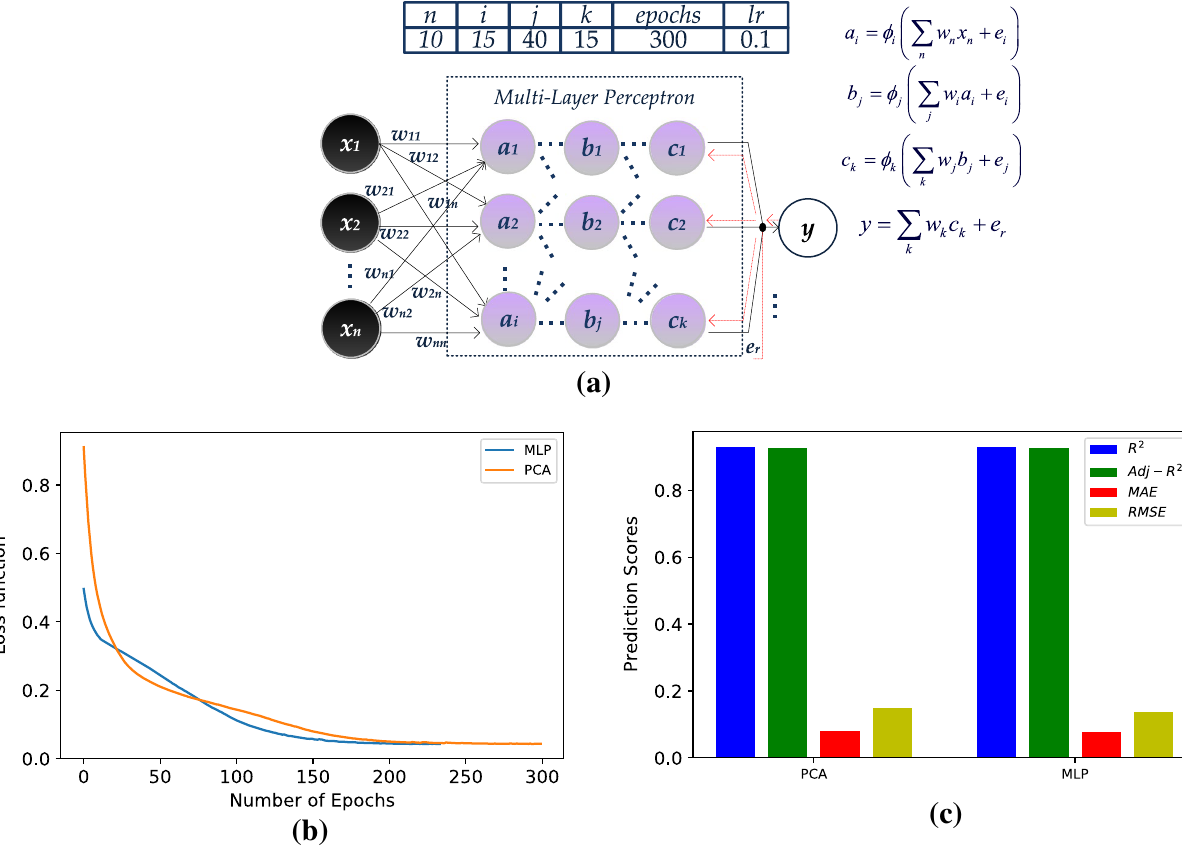
Figure 2. Model and results for the Multi-Layer Perceptron (MLR), ( a ) data flow, ( b ) loss functions, and ( c ) bar plot, quantifying R 2 , Adj-R 2 , MAE, and RMSE for the MLP and the PCA